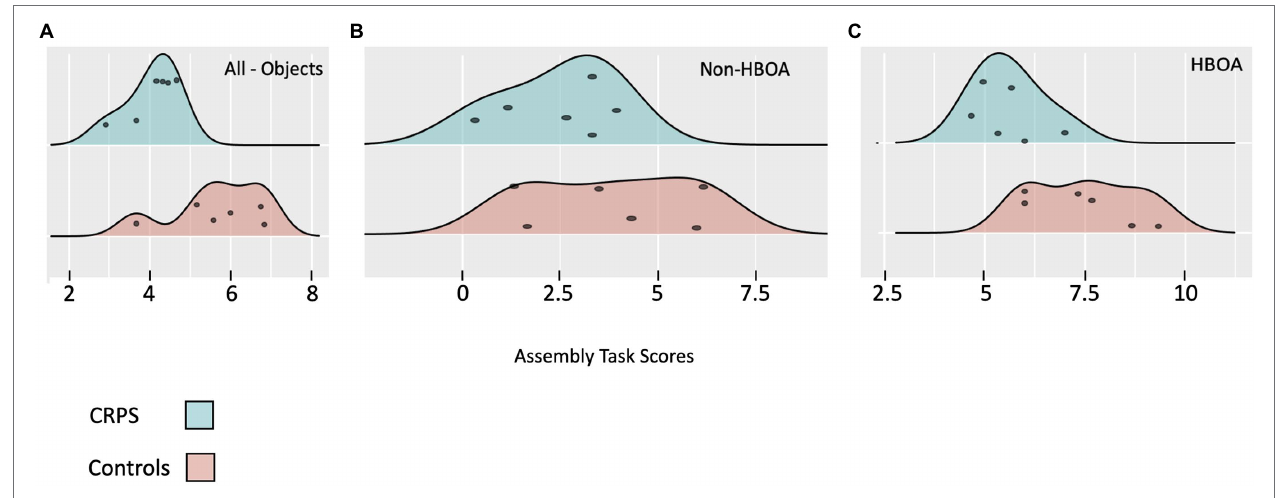
FIGURE 2 | Performance on the Assembly Task presented in a rain cloud plot. Panel A —results for all objects; Panel B —Results for the Non-Human Body Objects Assembly (Non-HBOA); Panel C —Results for the Human Body Objects Assembly